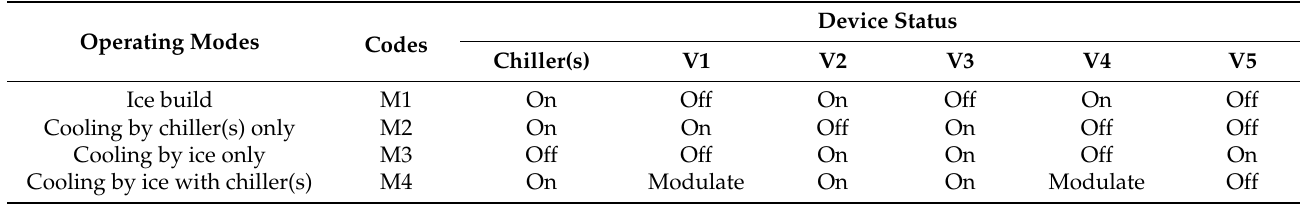
Table 1. System operating modes and corresponding control logic.